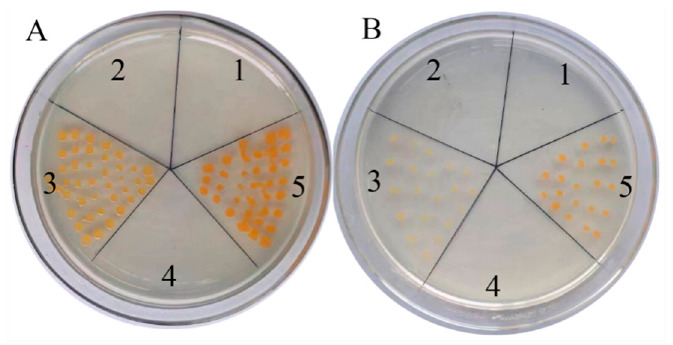
Figure 3. Function demonstrantion of CoDXS ( A ) and CoDXR ( B ) in E. coli . The E. coli Top 10 was transformed with pTrc ‐ Co DXS and pAC ‐ BETA harboring CoDXS (A5) or pTrc ‐ CoDXR and pAC ‐ BETA harboring CoDXR (B5) pTrc and pAC ‐ BETA (A3, B3), pAC ‐ BETA (A4, B4), pTrc ‐ Co DXS (A2), pTrc ‐ Co DXR (B2), and pTrc (A1, B1), respectively.